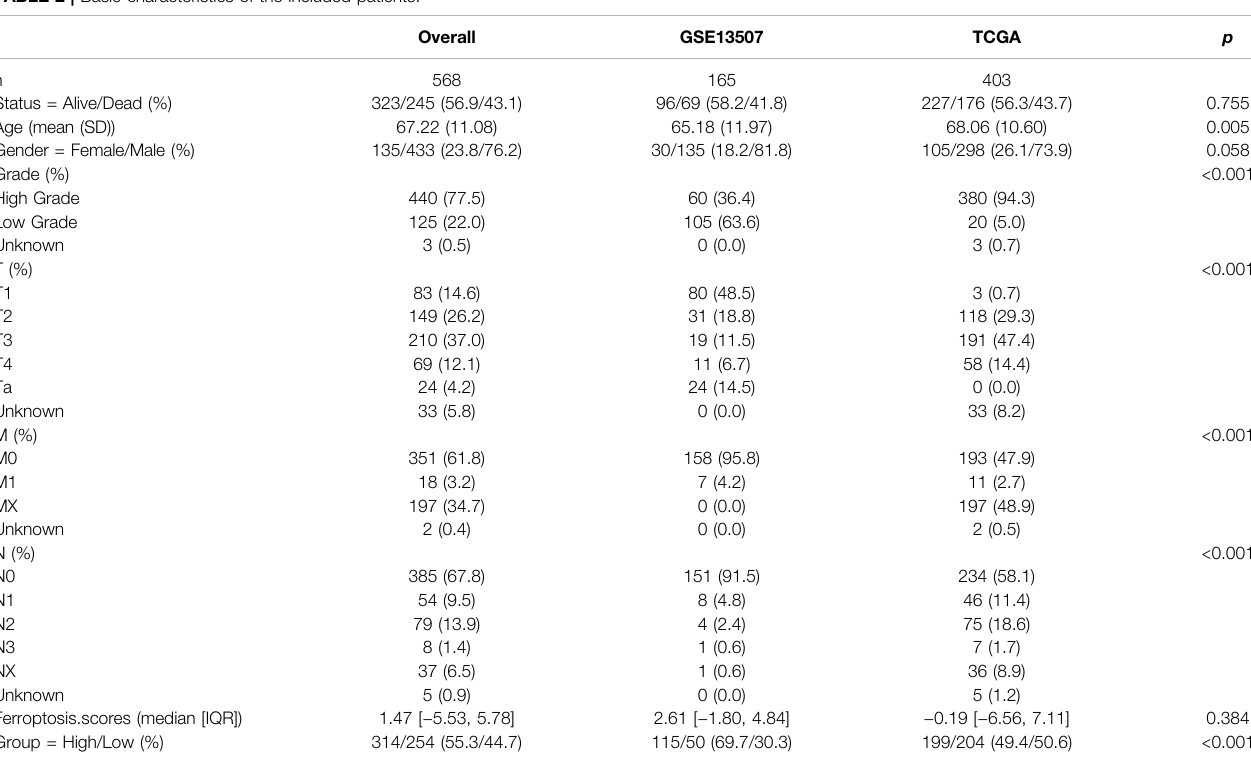
TABLE 2 | Basic characteristics of the included